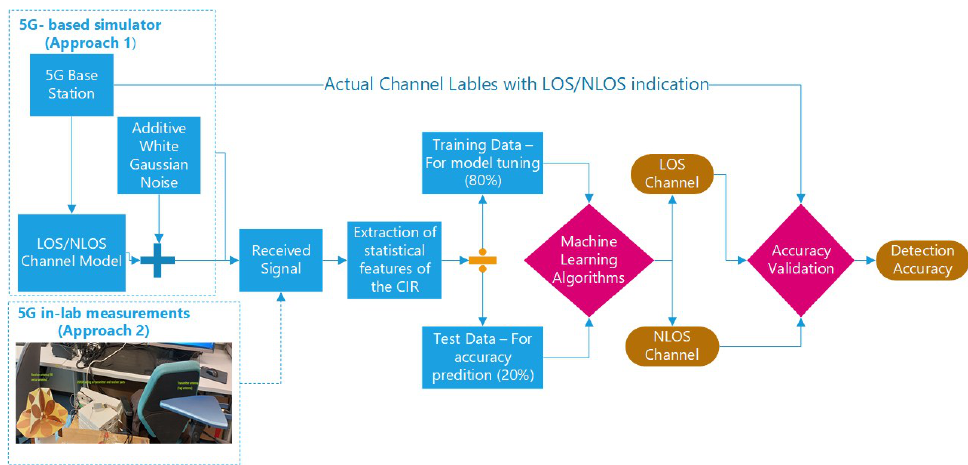
Figure 2. Flowchart of the applied simulation-based and measurement-based methodology.